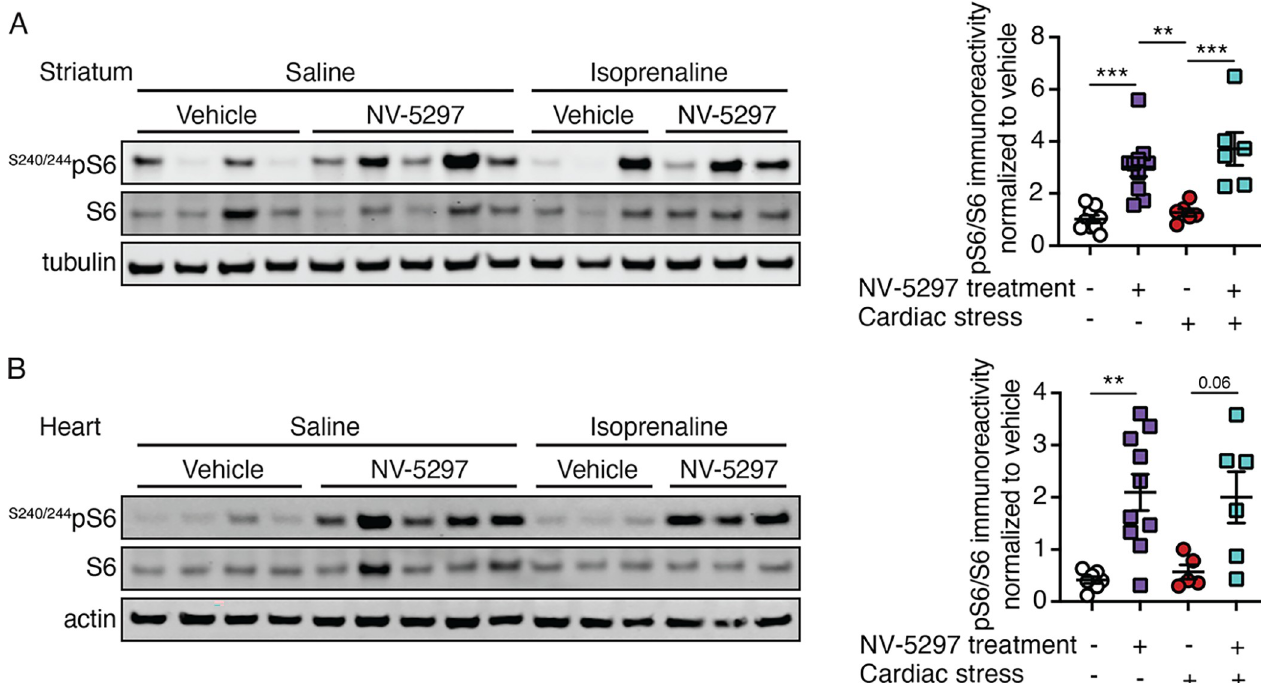
Fig 8. mTORC1 pathway activation following NV-5297 dosing and cardiac stress in the striatum but not heart. Representative immunoblot (left panels) of phosphorylated S6 ( S240/244 pS6) and quantification of normalized level (right panels) for homogenized heart (A) and striatum (B ) isolated 1 hour after oral dosing with NV-5297 (160 mg/kg) with a saline (n = 10) or isoprenaline (n = 6) implant or treated with vehicle and an isoprenaline implant (n = 6) normalized to loading control levels and further normalized to vehicle treated mice with a saline implant (n = 9). Data are presented as mean ± SEM. � P � 0.05, �� P � 0.01, ��� P � 0.001 (Mixed-effects model with Sidak’s multiple comparisons